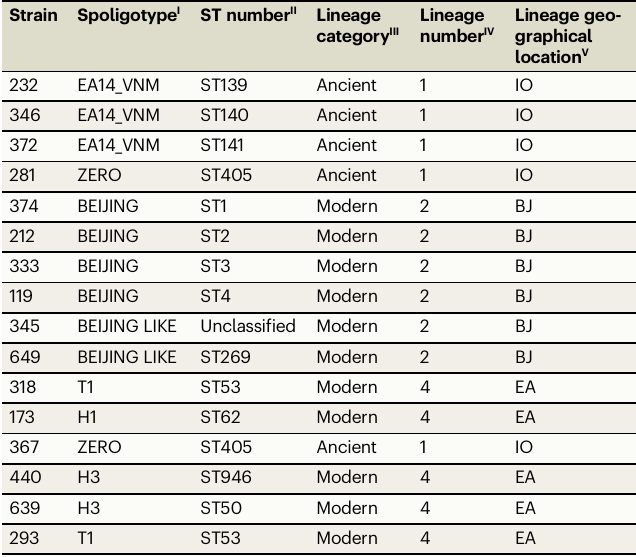
Table 1 | Genotypes of the selected Mtb clinical isolates strains used in this